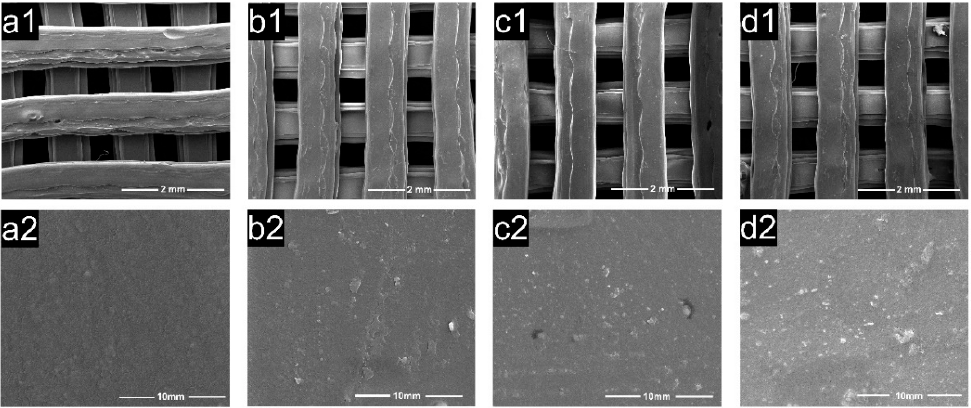
Figure 6. SEM of ( a ) PLA (( a1 ) 60 × , ( a2 ) 10,000 × ); ( b ) PDA/PLA-4 h (( b1 ) 60 × , ( b2 ) 10,000 × ); ( c ) PDA/PLA-8 h (( c1 ) 60 × , ( c2 ) 10,000 × ); ( d ) PDA/PLA-12 h (( d1 ) 60 × , ( d2 ) 10,000 × ).